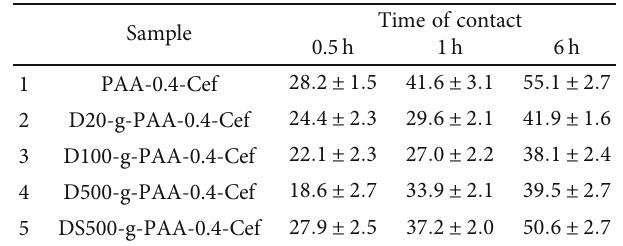
Table 1: Temperature intervals of weight loss on heating, obtained by the DTA